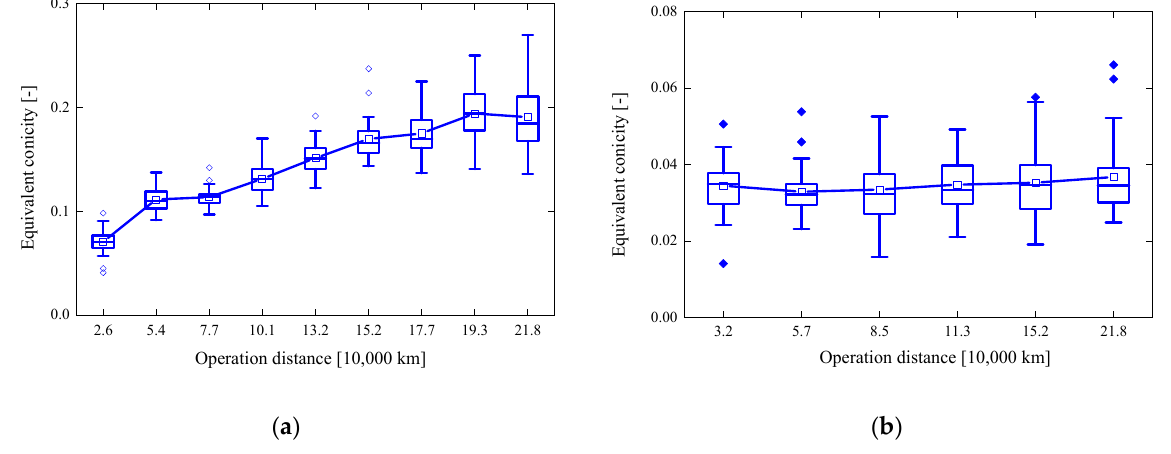
Figure 6. Equivalent conicity revolution of different railway lines: ( a ) Line A; ( b ) Line B.